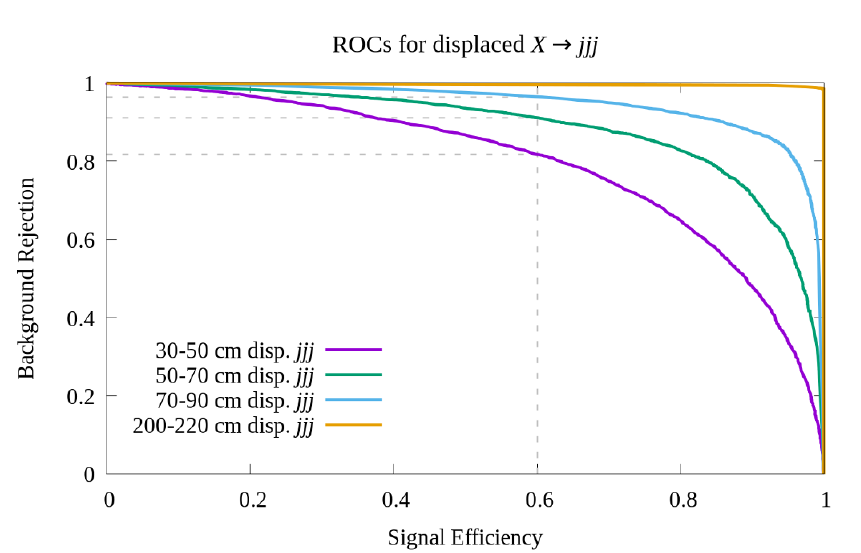
Figure 11. ROCs of the CNN performance to separate non-displaced jjj from di(cid:11)erent classes of displaced jjj